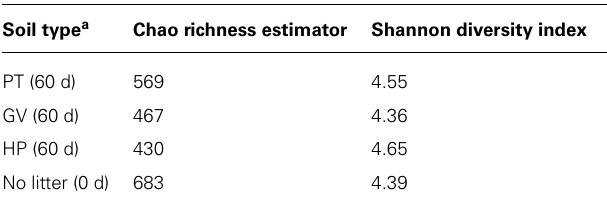
FIGURE 3 | Principal coordinate analyses of bacterial (A) and fungal (B) communities found in microcosms with soil and leaf litter from Populus tremuloides . Communities correspond to soil in microcosms before incubation (0 d) and without added litter (Control), and soil from microcosms incubated for 60 d, with litter either from parental type (PT) saplings or transgenic poplar possessing either a simple GUS vector (GV) or higher expression of proanthocyanidins